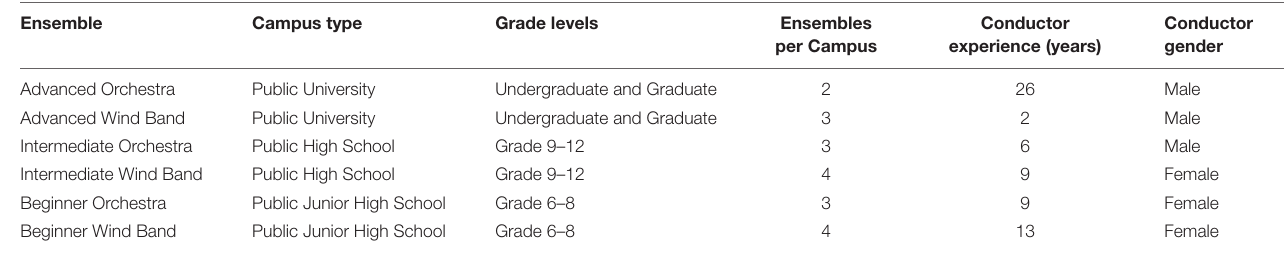
TABLE 1 | Ensemble location and conductor